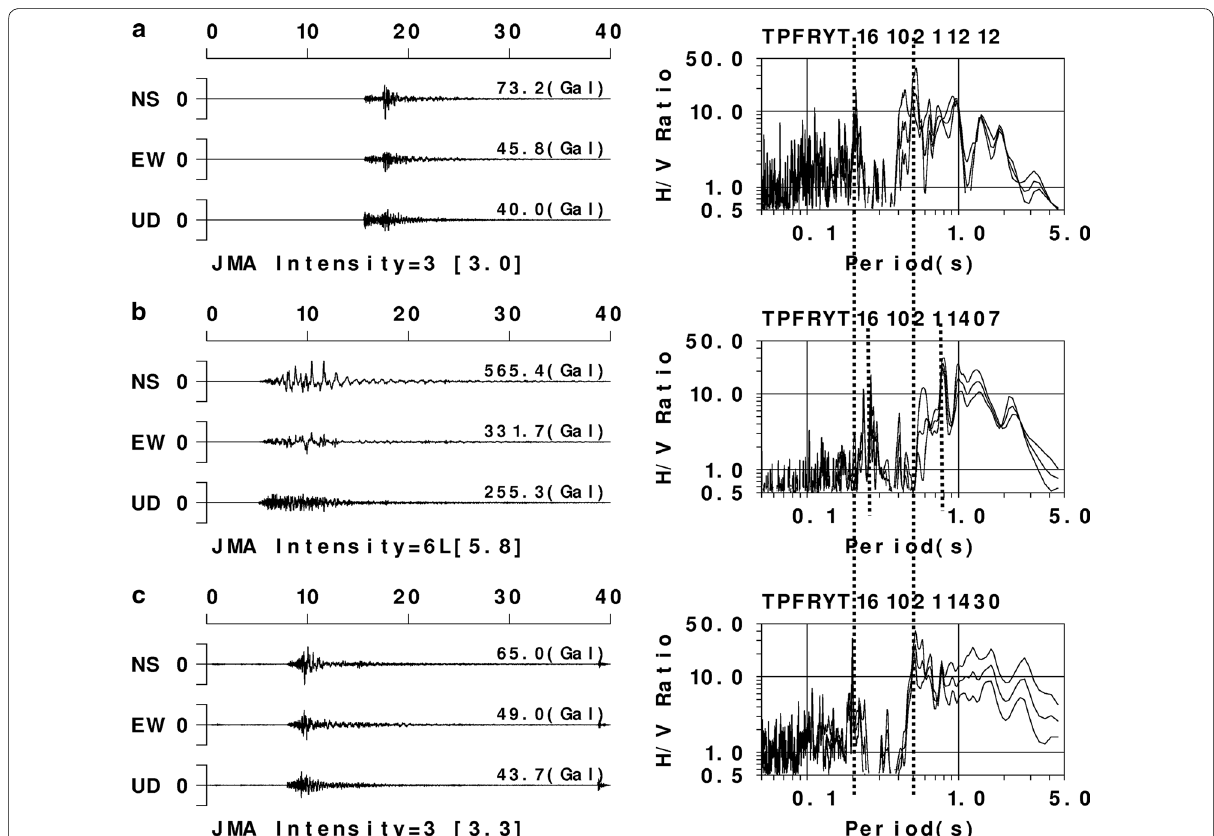
Fig. 3 Observed accelerations for the a foreshock at 12:12 JST, b main shock at 14:07 JST, and c aftershock at 14:30 JST at the Togo branch (Ryuto, Yurihama Town). The right-hand panels show the observed H/V spectra based on three evaluations of horizontal components: north–south, east– west, and average. The vertical dashed lines indicate the two distinguished peak periods of the fore- and